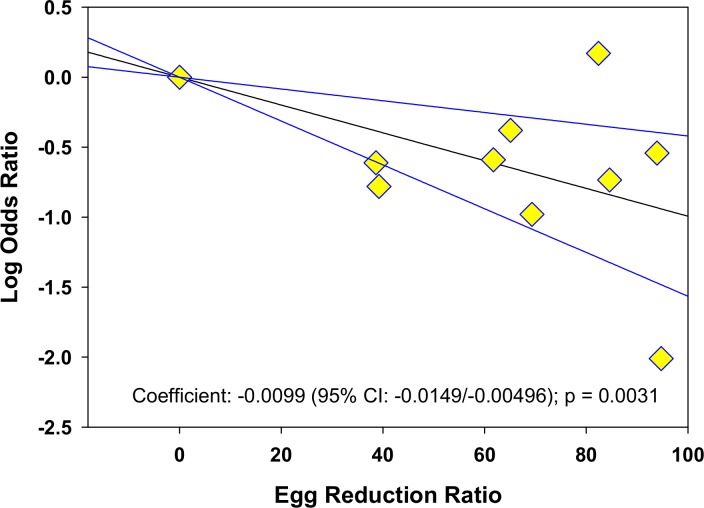
Log odds ratio of periportal fibrosis according to post-treatment egg reduction rate.The graph shows the log10 of the post-treatment/pre-treatment odds ratio for periportal fibrosis according to each study’s post-treatment egg reduction rate (ERR), n = 10.